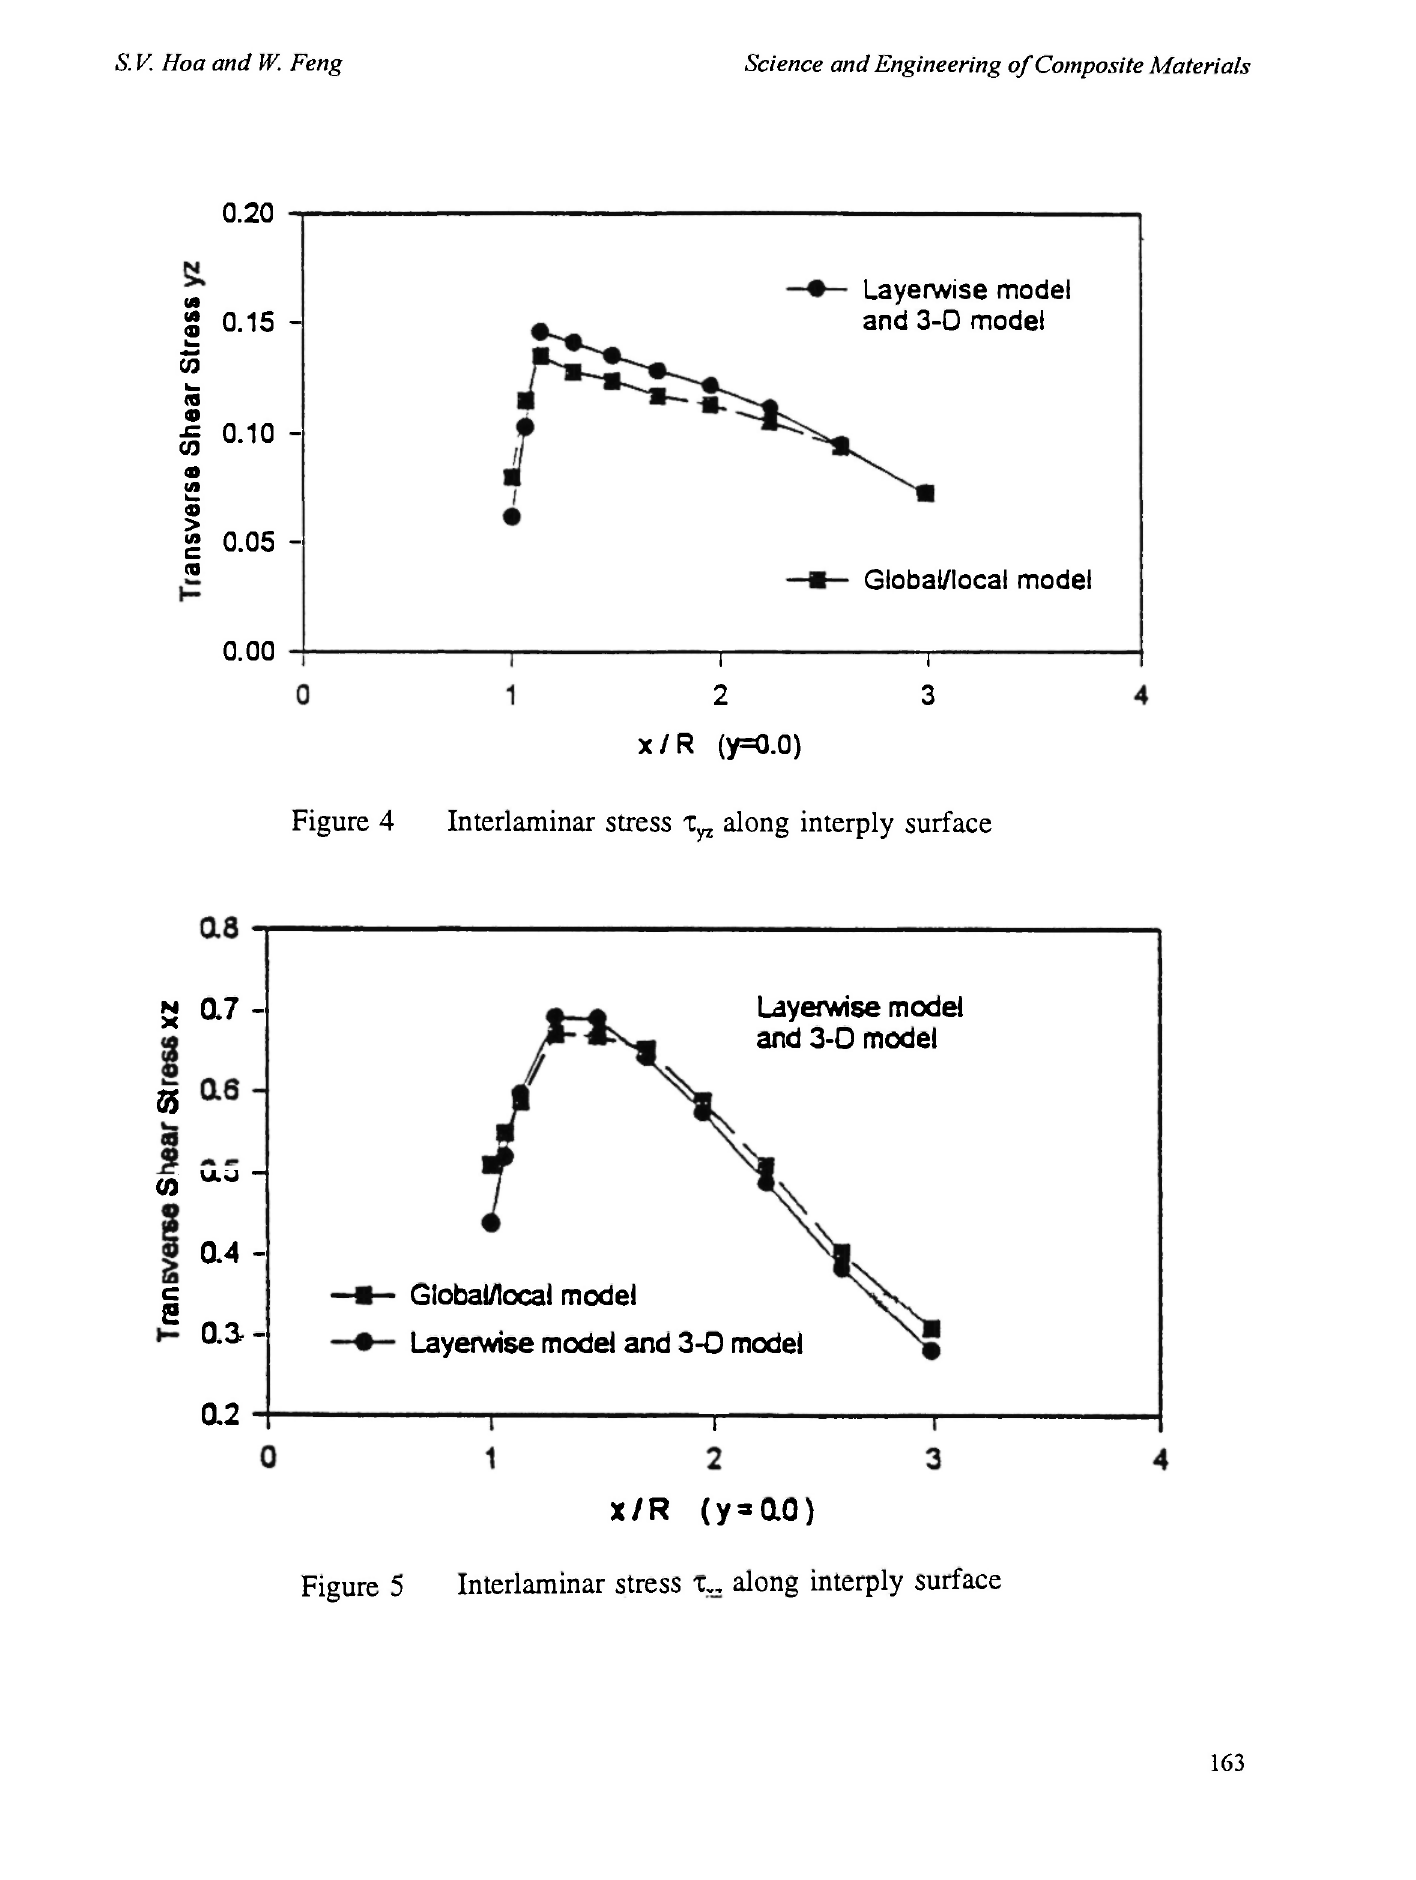
Interlaminar stress τ^ along interply